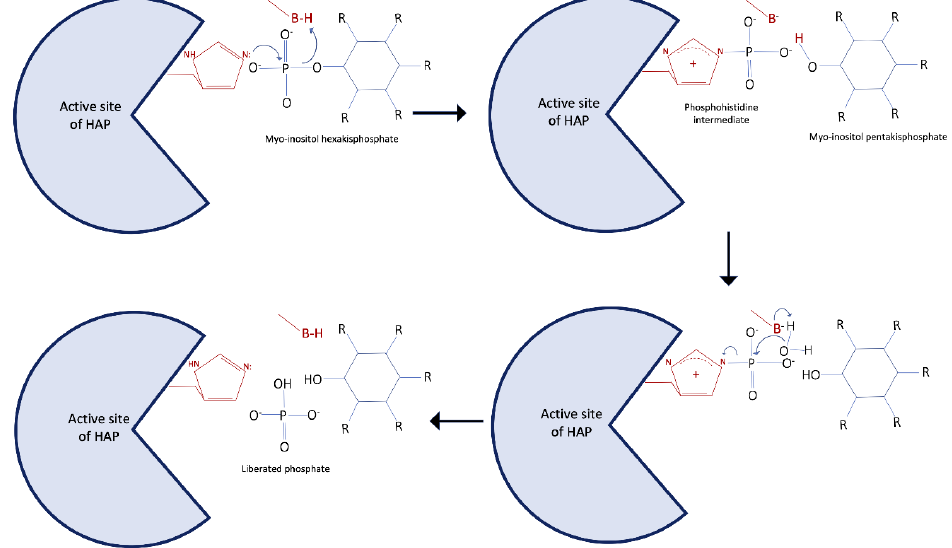
Figure 1. Catalytic mechanism of histidine acid phosphatases. Histidine residue of the conserved RHGXRXP motif acts as a nucleophile and forms phosphohistidine intermediate. The intermediate is hydrolyzed after the water molecule attacks the phospho group of the phosphohistidine to generate a free